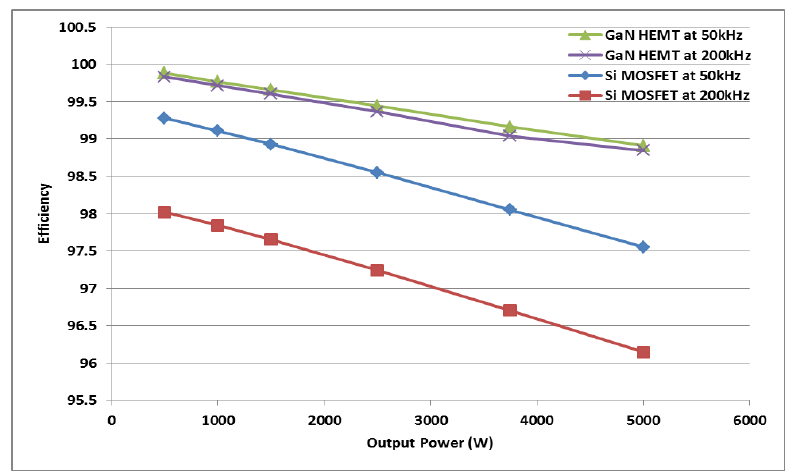
Figure 10. Efficiency comparison of Si MOSFET and GaN HEMT at different switching frequency.